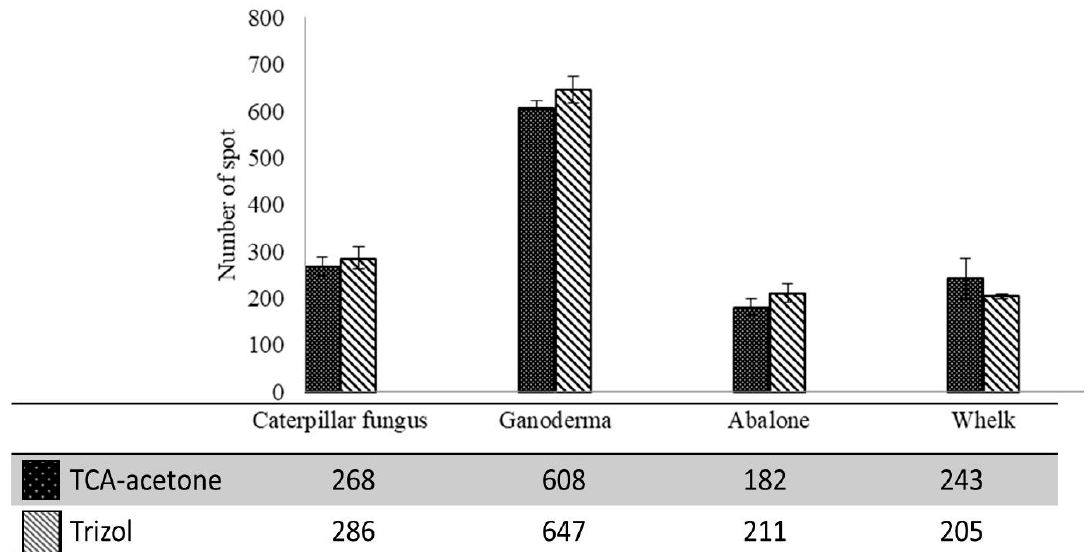
Figure 2. Total spot numbers on the 2-DE of caterpillar fungus, ganoderma, abalone, and whelk samples. Results were the average of values from three independent